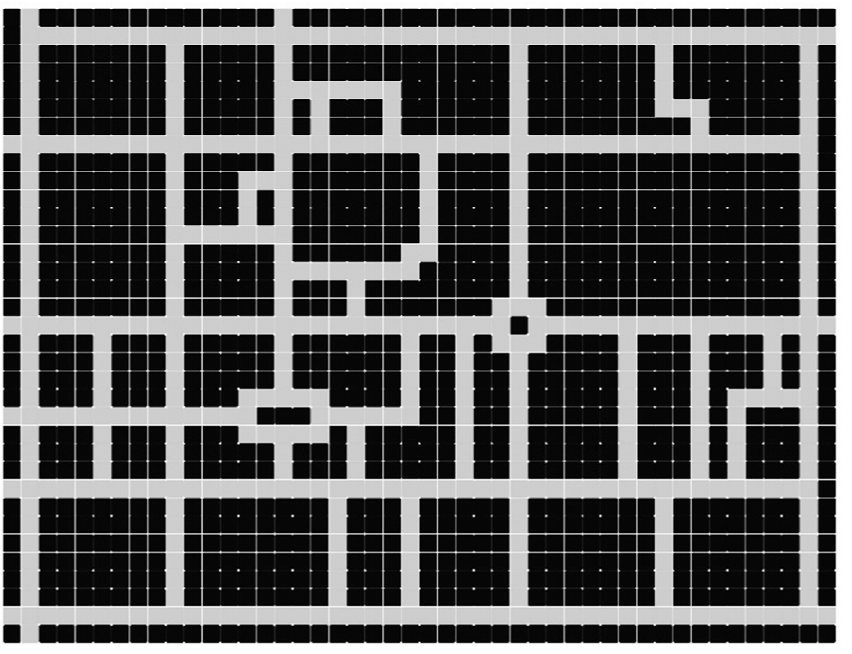
Figure 11. Results of compressed rasterization.